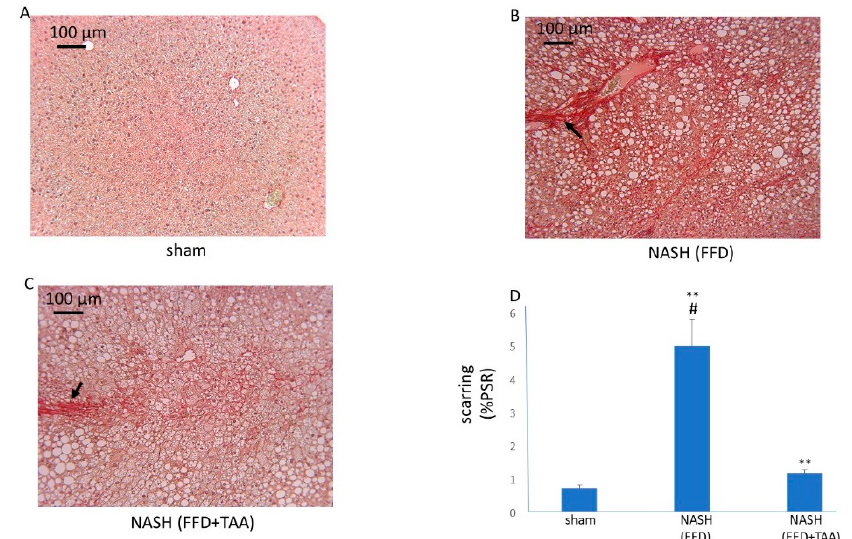
Figure 3. Liver scarring. Representative images (10 × ) of PSR-stained liver sections from mice randomized to a standard diet ( A ), FFD (B) or FFD + TAA. ( C ) The black arrow ( B ) shows bridging fibrosis. ( D ) Quantitation of PSR staining shows elevated scarring in the FFD and FFD + TAA cohorts. ** p < 0.01 vs. sham. # p < 0.01 vs. FFD + TAA.